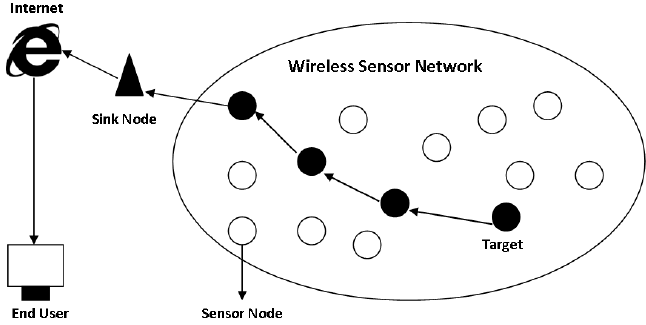
Figure 1. Wireless sensor network (WSN) System Architecture.